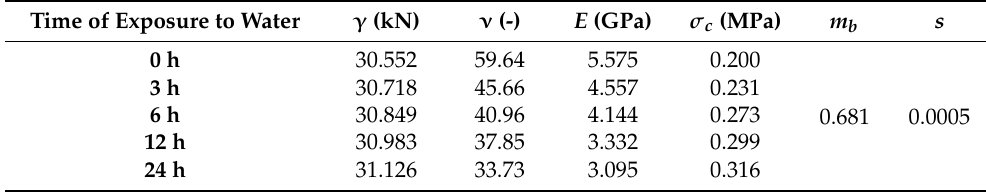
Table 7. Geomechanical parameters of claystone from the floor of the roadway F-33 versus time of soaking with water.